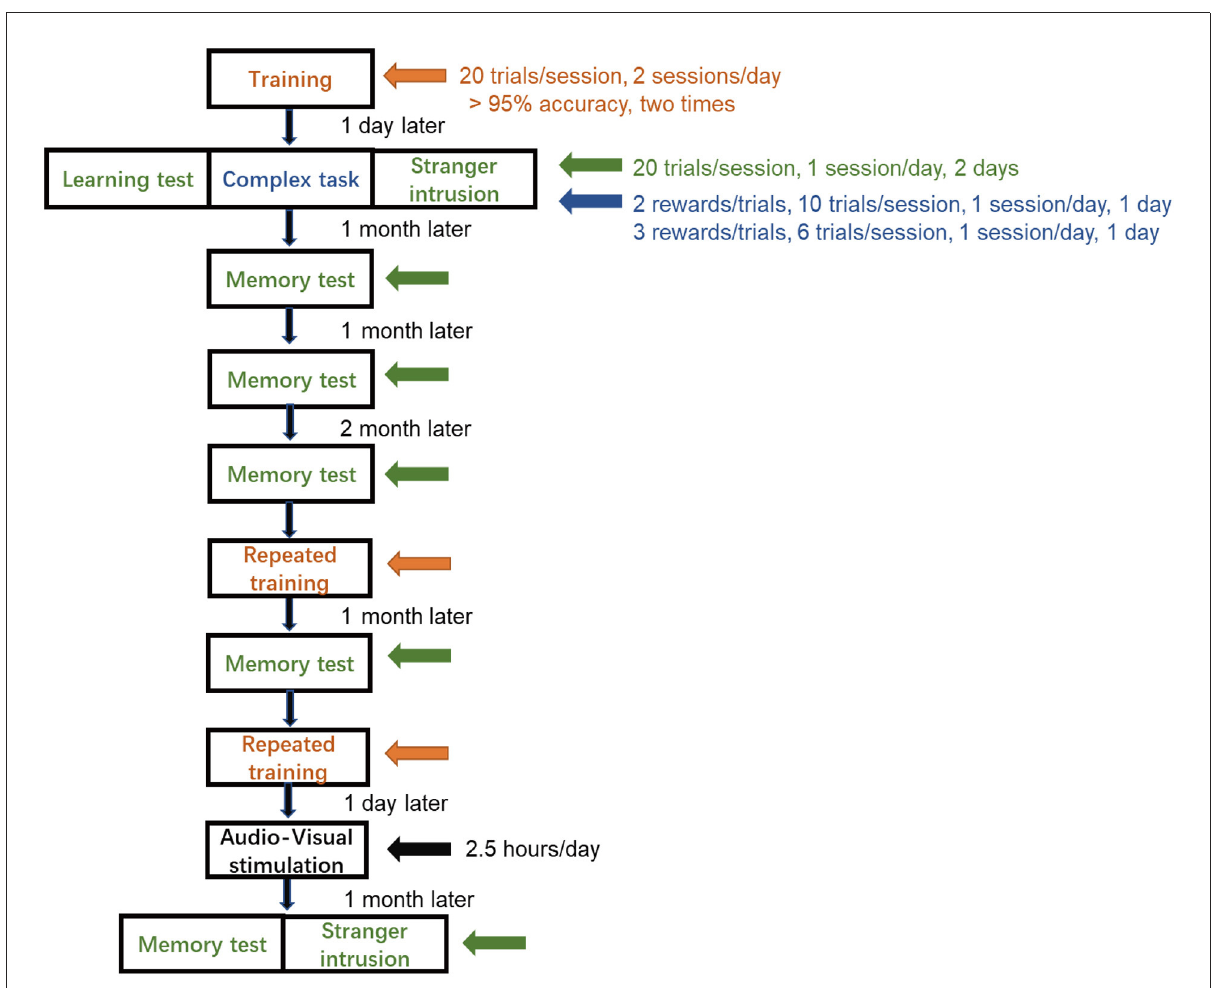
FIGURE2 Schedule of finger maze test. The monkeys did not complete the training until the success rate achieved more than 95% accuracy for two consecutive sessions and proceeded to the learning test, the complex task test, and the stranger intrusion interference test, each for 2 days. Memory tests were performed at a specific time. Repeated training was followed by audio-visual stimulation, and then, after 1 month, the memory test and the stranger intrusion interference test after stimulation were carried